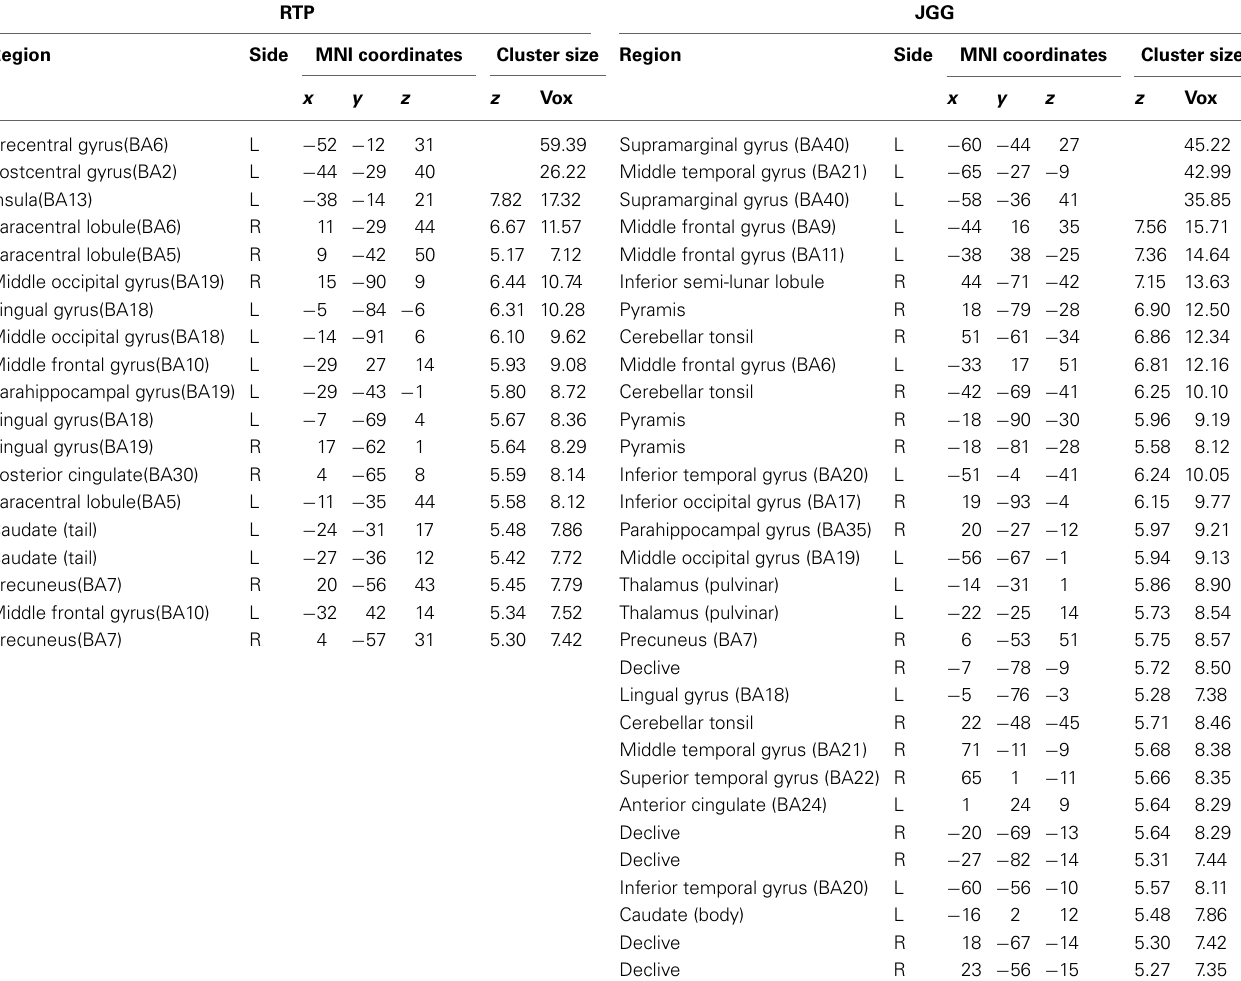
FEW p < 0.05 (corrected for multiple comparisons). Localization is based on stereotactic coordinates MNI (Montreal Neurological Institute). These coordinates refer to the location of maximal decrement metabolic activity indicated by the Z score in a particular anatomic structure. Distances are relative, to the intercommissural (AC-PC) line in the horizontal (x), anterior-posterior (y) and vertical (z) directions.